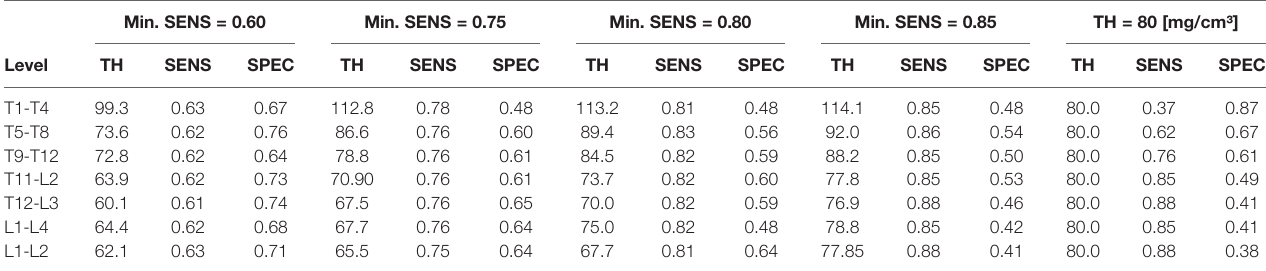
TABLE 6 | First four columns: vBMD threshold (TH; mg/cm³) for fi xed minimal sensitivities (SENS) of 0.60, 0.75, 0.80 and 0.85, along with corresponding speci fi cities (SPEC). Right column: sensitivities and speci fi cities for a fi xed vBMD threshold of 80 mg/cm³. Min. SENS = 0.60 Min. SENS =